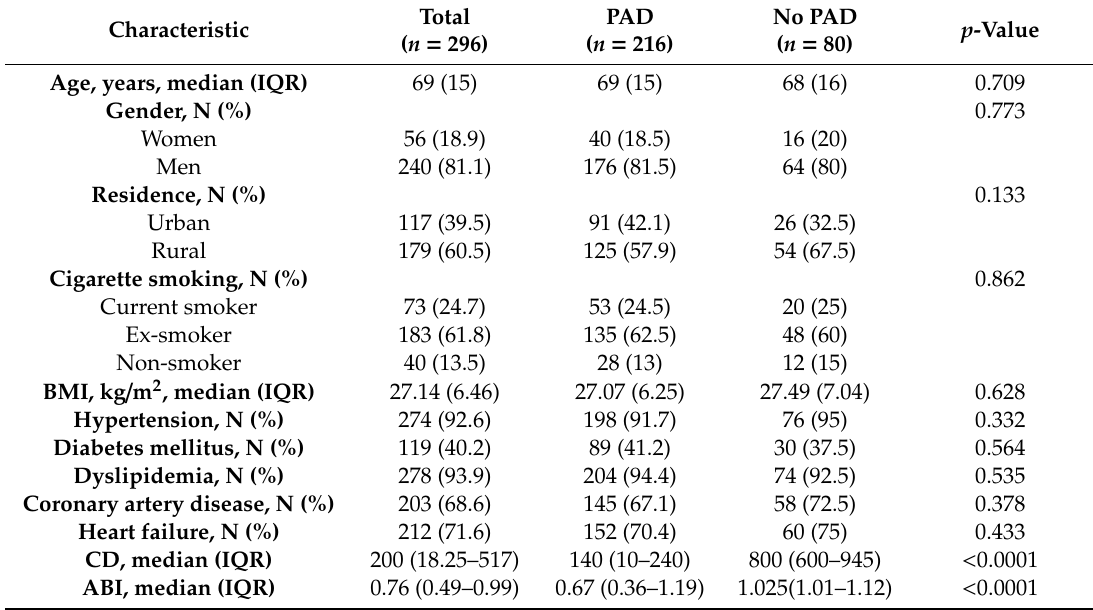
Table 1. Baseline characteristics of patients with PAD and control